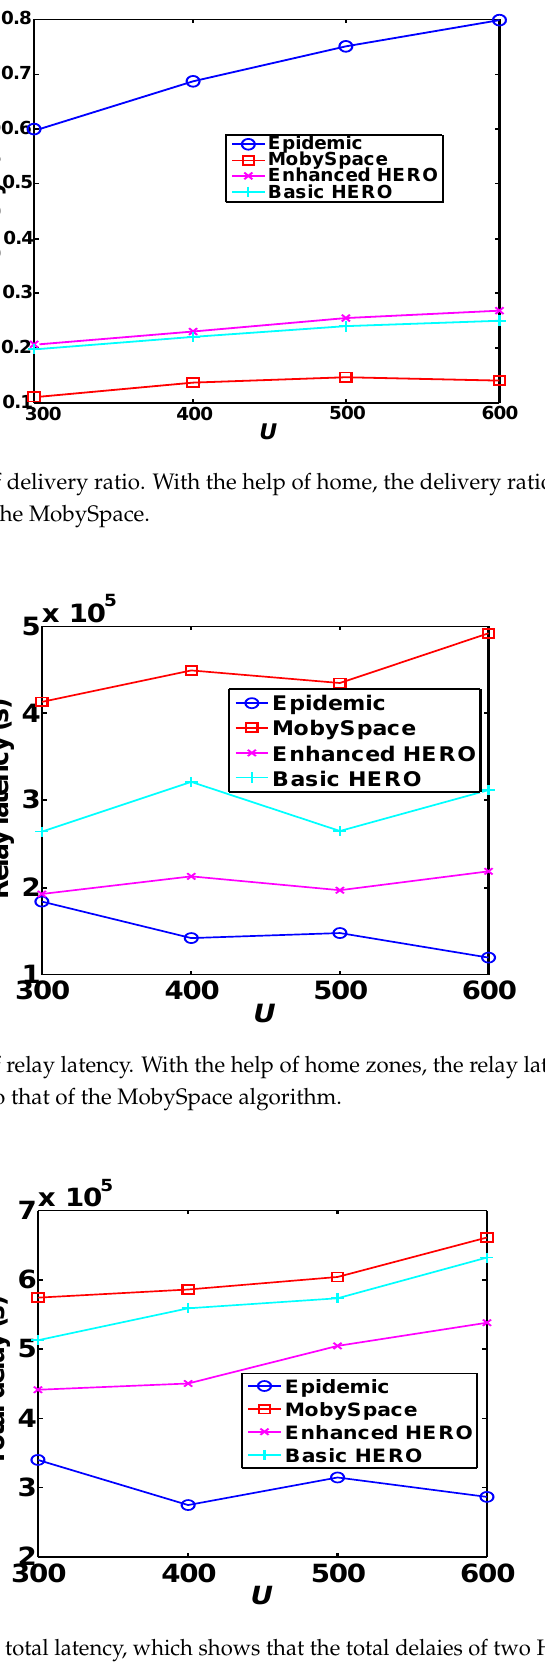
Figure 12. Comparison of total latency, which shows that the total delaies of two HERO algorithms are better than that of the MobySpace